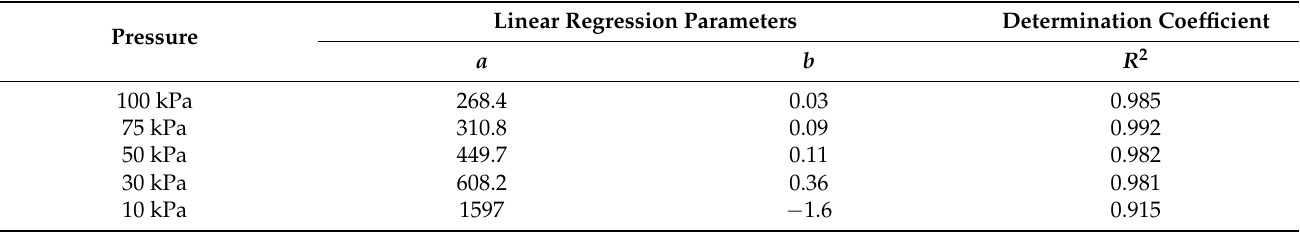
Table 3. Main parameters of the linear regression y = ax + b between the normalized intensity and the square root of the electrical energy of the discharges for ETFE insulated